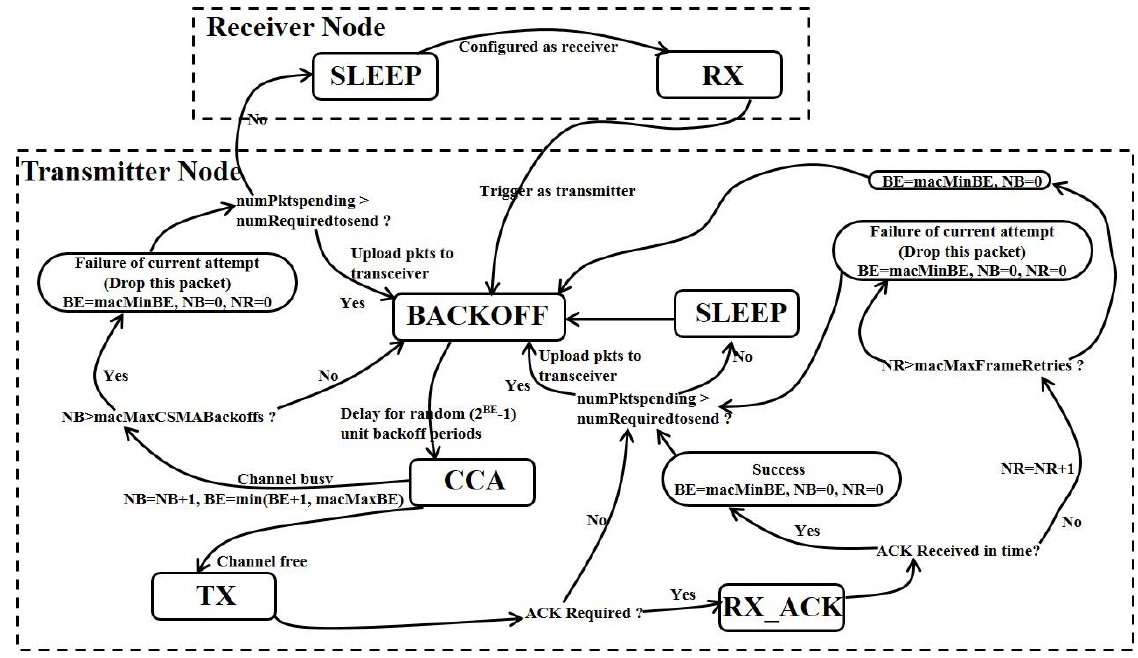
Figure 6. Unslotted CSMA/CA algorithm